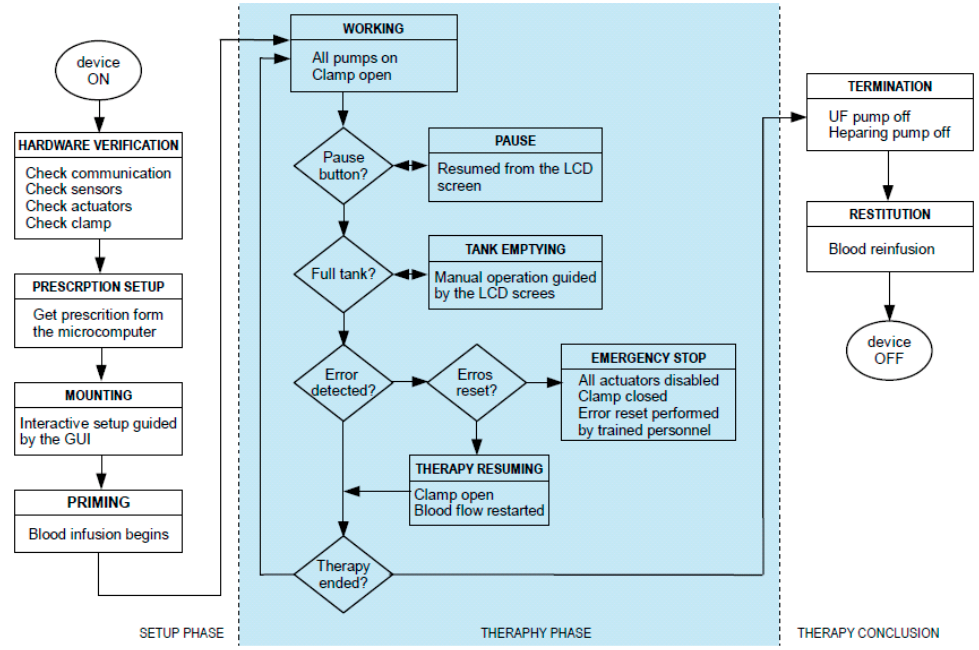
Figure 7. Workflow of the control architecture.